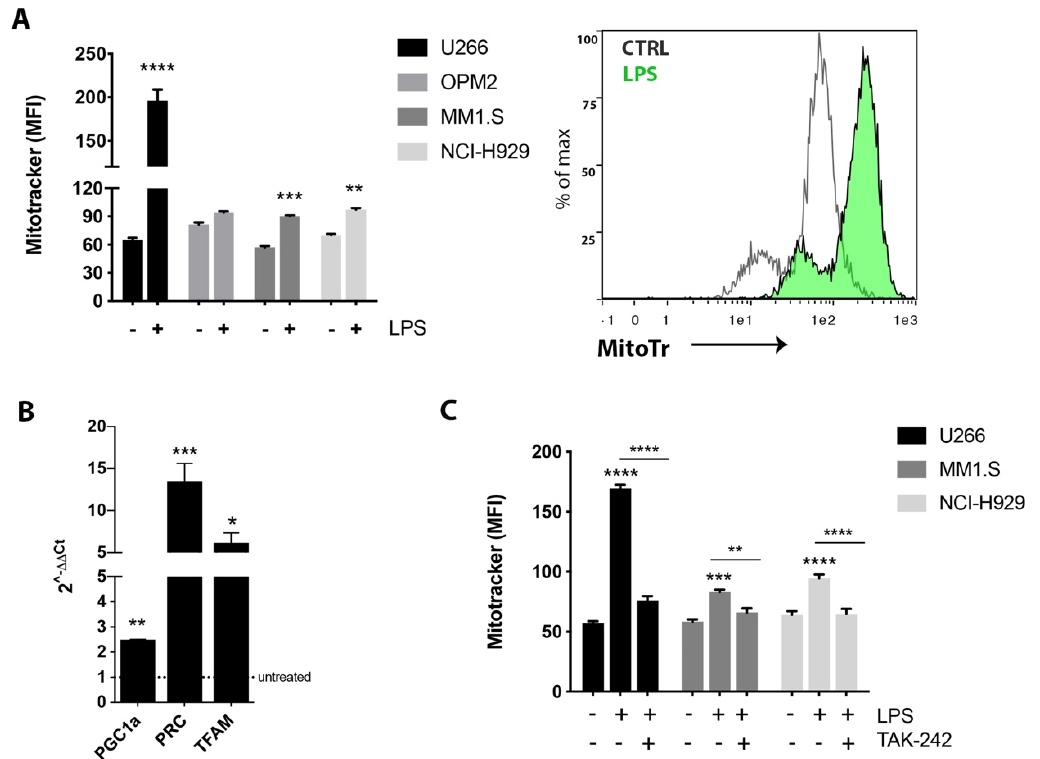
Figure 1. Toll-like receptor 4 (TLR4) activation increased mitochondrial biogenesis in MM cell lines. ( A ) Flow cytometric analysis of Mitotracker Red CMXRos staining after treatment with 2 µ g / mL lipopolysaccharide (LPS) for 24 h. A representative flow cytometry histogram shows the comparison of Mitotracker red fluorescence of control vs. LPS treated in U266 cell line. ( B ) Gene expression analysis of mitochondrial biogenesis markers in U266 cells after 6h LPS treatment. B2M gene was used as housekeeping gene. Calculated value of 2ˆ − ∆∆ Ct in untreated cells was 1. ( C ) Flow cytometric analysis of Mitotracker Red CMXRos staining after treatment with LPS alone or in combination with 10 µ M TAK- for 24 h. Bars indicate the standard error means. * p < 0.05; ** p < 0.01; *** p < 0.001; **** p < 0.0001.